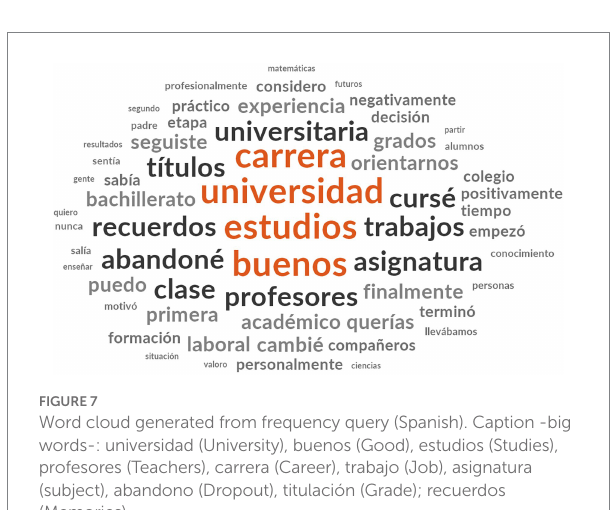
FIGURE 7 Word cloud generated from frequency query (Spanish). Caption -big words-: universidad (University), buenos (Good), estudios (Studies), profesores (Teachers), carrera (Career), trabajo (Job), asignatura (subject), abandono (Dropout), titulación (Grade); recuerdos